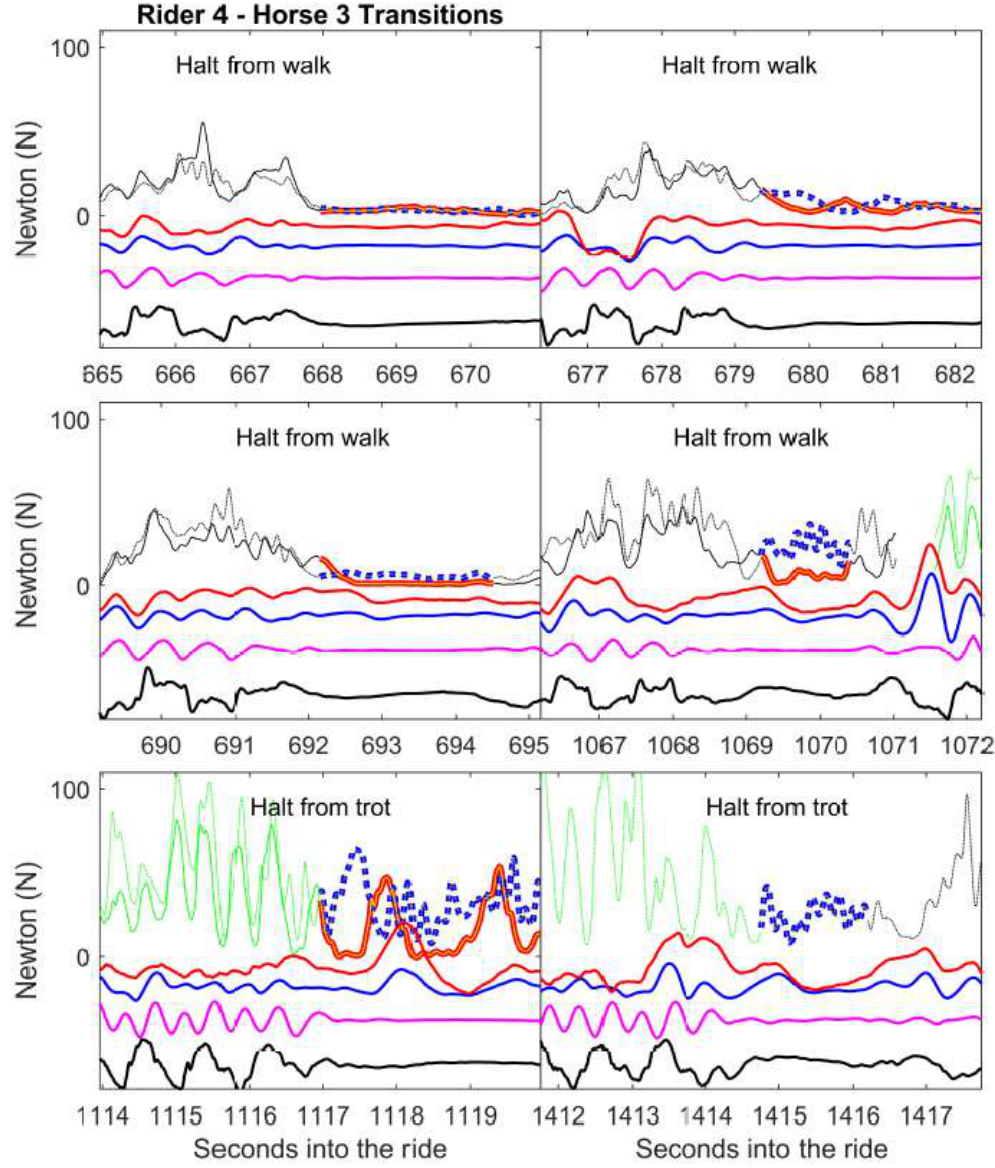
Figure 2. Examples of rein tension signals in transitions to halt. Within the six graphs (data from horse 3 / rider 4), the upper curves show left (solid line) and right (dotted line) rein tension (N) before and during halts. The bolded part represents the halt / standstill (red / blue left / right rein). Black represents walk, and green is trot. Rein data gaps represent other transitions, halts or unidentified gaits. The curves in the lower part of the graphs represent dimensionless traces for the poll (blue) and croup (magenta) heights, croup roll (black, positive values represent downward motion of the left hip) and nose angle (red, positive forwards / nose out). Data are missing for the left rein in the last graph.